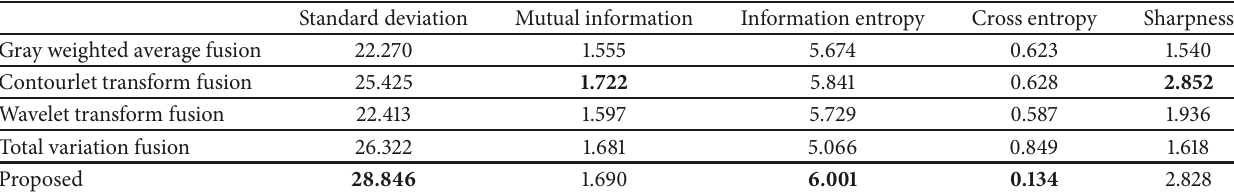
Table 5: Average evaluation value of different fusion methods at